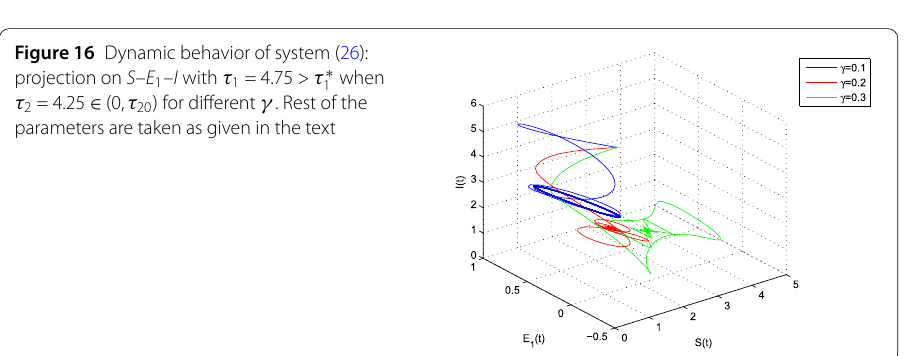
keeps static along with the increment of b when τ 1 > 0 and τ 2 = 0. We can also observe that oscillations and delay can be reduced and removed by decreasing the value of b , which is illustrated by Fig. 6. Figure 7(a–d) describe the effect of the recovery rate of the infectious nodes γ on system dynamics and show that the susceptible class increases, whereas the infected class of short latent period, the infected class of long latent period, and the infec- tious class decreases when τ 1 > 0 and τ 2 = 0. Also, oscillations and delay can be reduced and removed by increasing the value of γ , which is illustrated by Fig. 8. The effects of b and γ on system dynamics when τ 1 = 0 and τ 2 > 0, τ 1 > 0 and τ 2 ∈ (0, τ 20 ), and τ 2 > 0 and ∈ (0, τ τ τ τ 1 10 ) are the same as those in the case where 1 > 0 and 2 = 0. The simulations